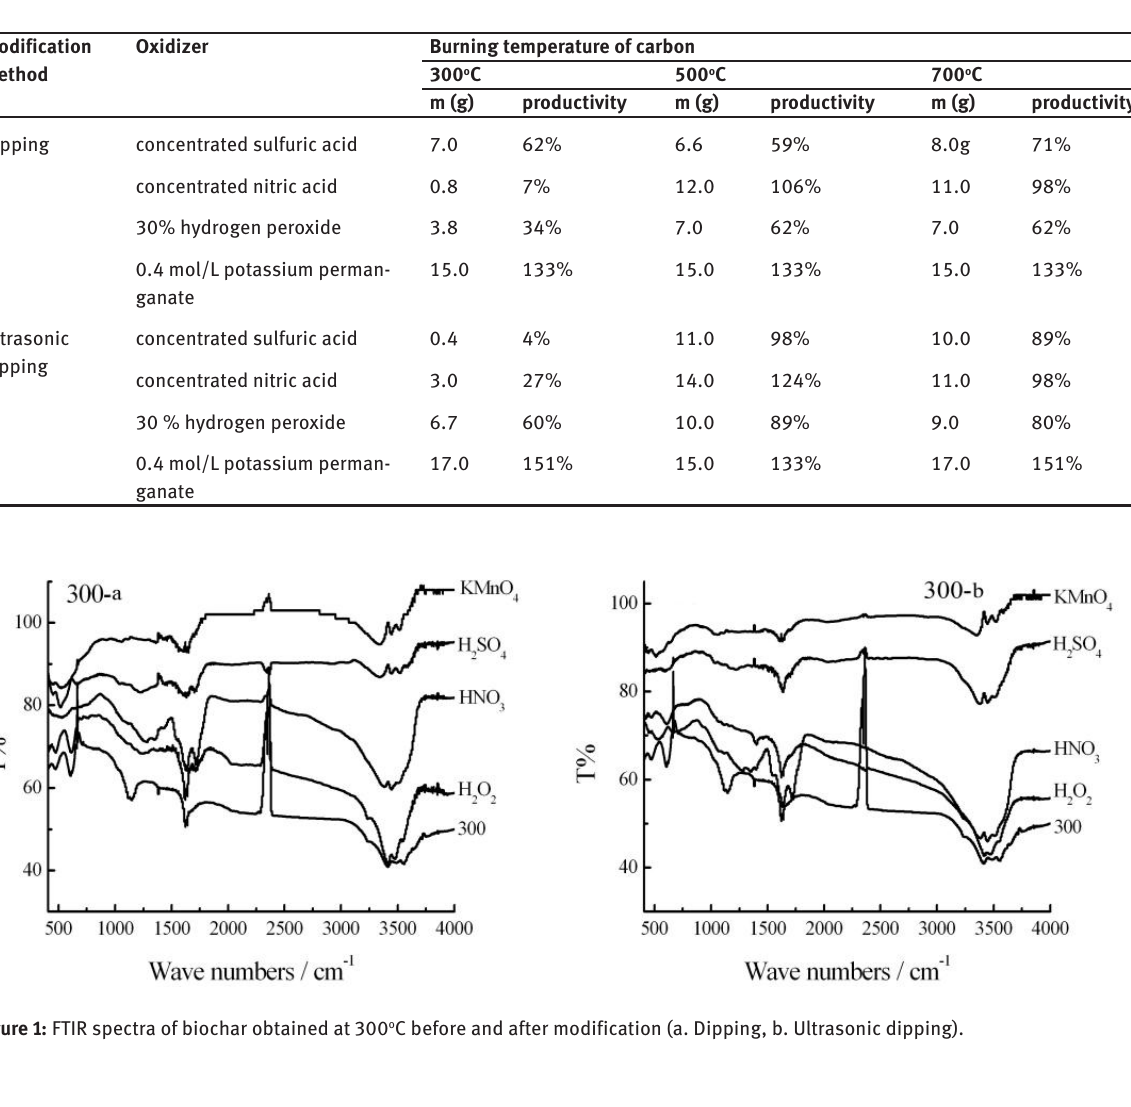
Table 1: The mass of modified biochar obtained and calculated productivity.